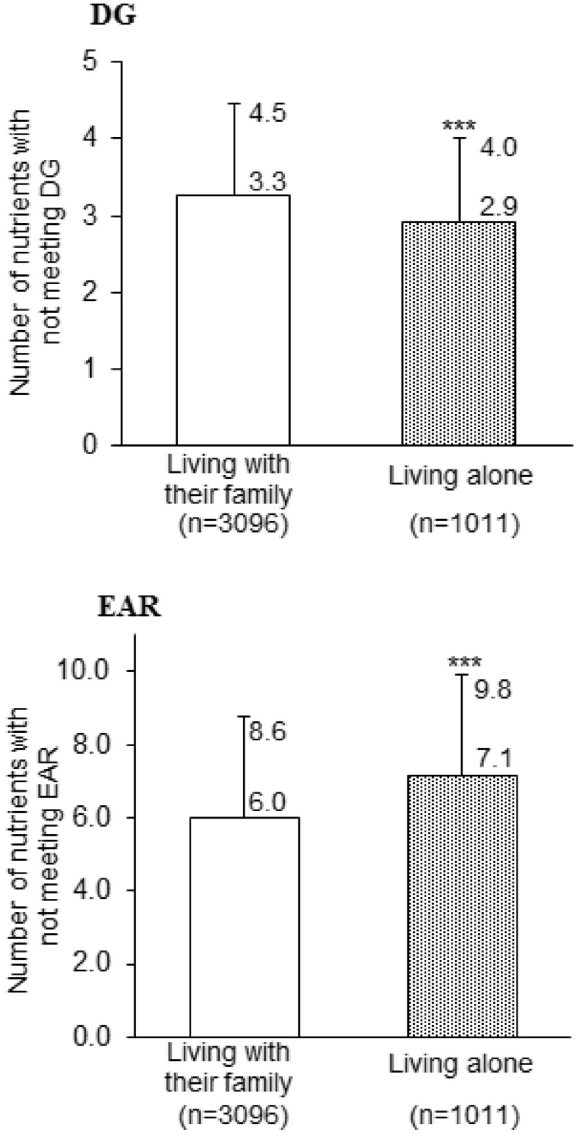
Fig. 1. The number of nutrients with not-meeting DG and EAR among 4,107 adult women living with their family or living alone. Signi fi cance of each value was compared using independent t -test (*** P < 0.001). DG, tentative dietary goal for pre- venting lifestyle-related disease; EAR, estimated average